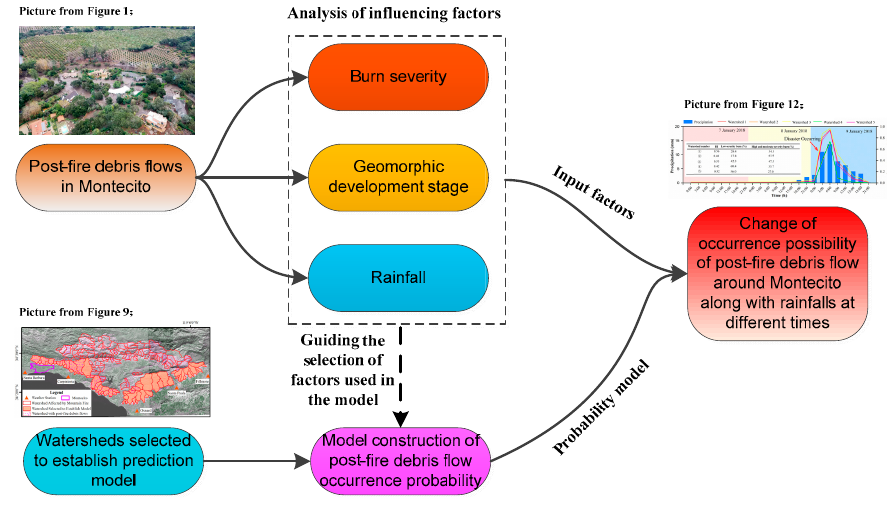
Figure 4. Technical route of this study.